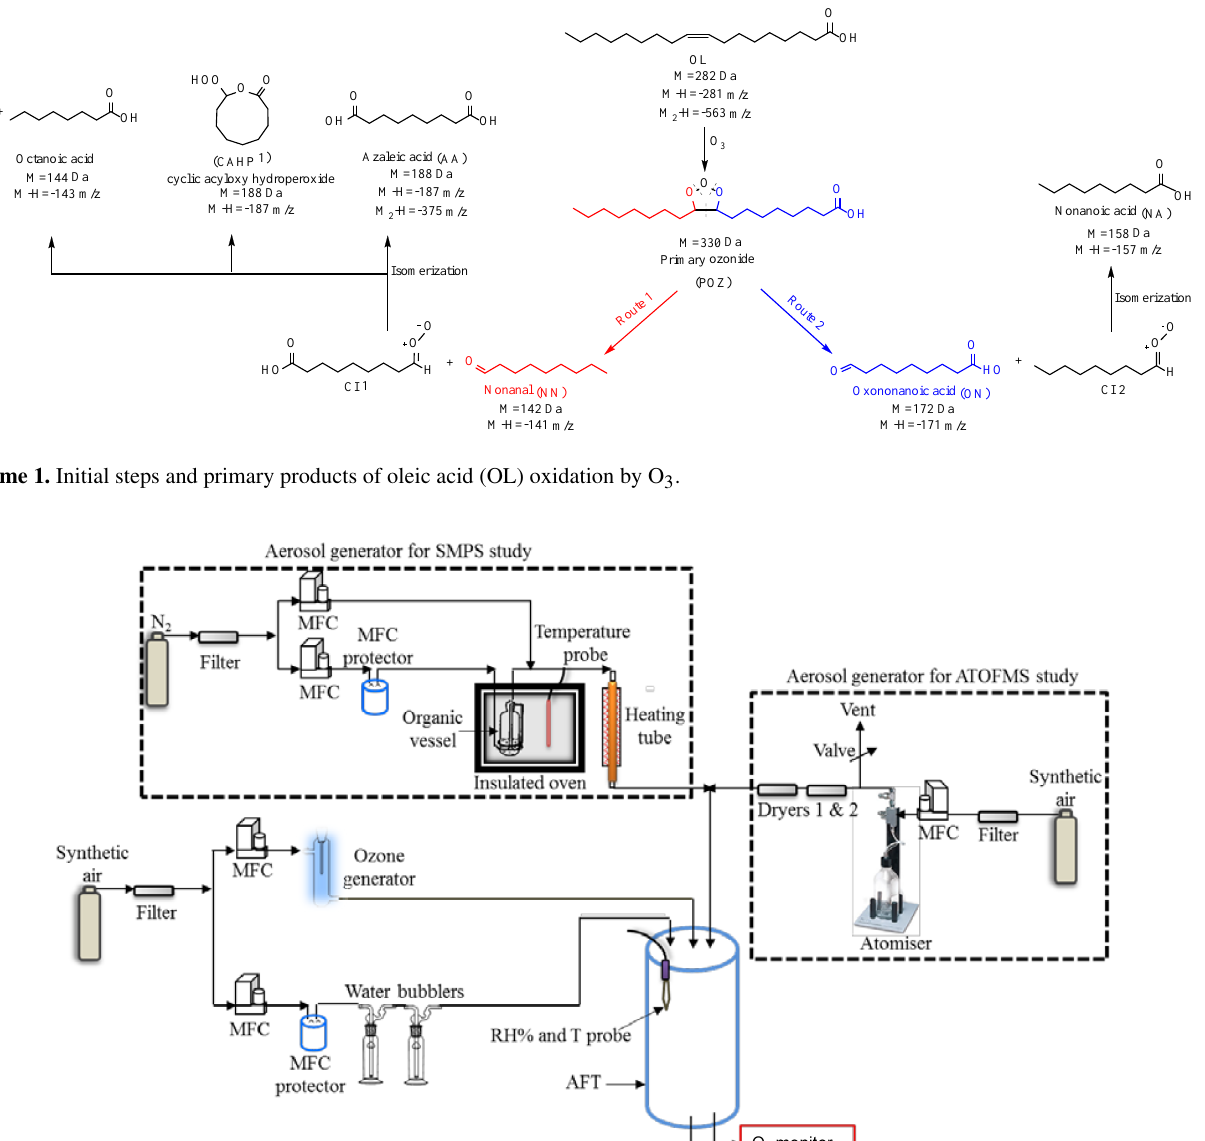
inar regime after an initial flow development length (esti- mated at 4.6 cm, i.e. < 5 % of the total length). To ensure that particle processing was dominated by the AFT section of the set-up, the additional residence time within the sampling and characterisation stages was assessed. The calculated residence time of the aerosol in the sampling tubes (< 2 s) and SMPS (< 1 s; von Hessberg et al., 2009) was negligible. Within the ATOFMS the residence time is very small, and the low operating pressures within the